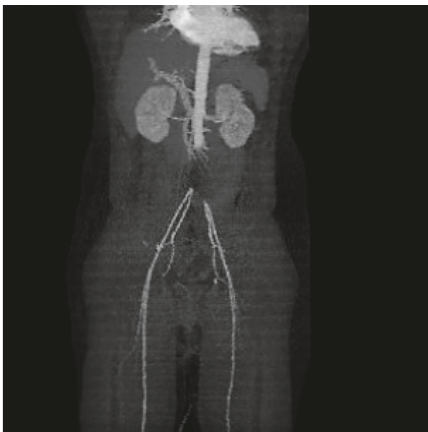
Figure1:CTangiographydepictedocclusionofinfrarenalaortaand aortoiliac bifurcation.